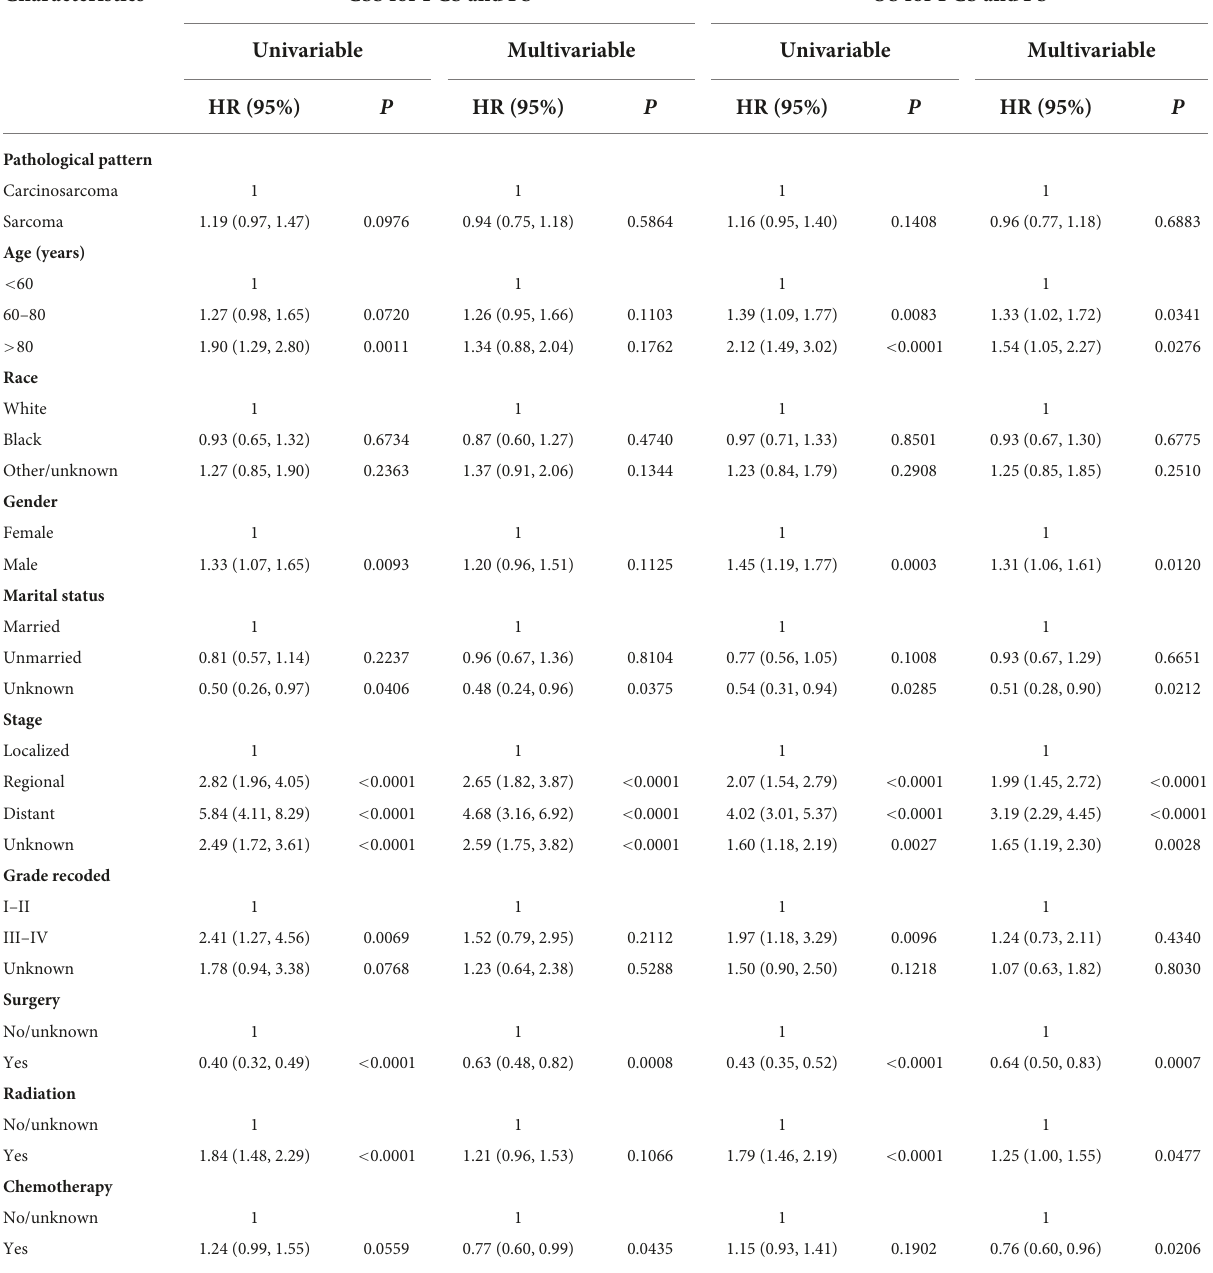
TABLE 2 Univariate and multivariate Cox analyses of CSS or OS for PSC and PS patients in matched cohorts. Characteristics CSS for PCS and PS OS for PCS and PS Univariable Multivariable Univariable